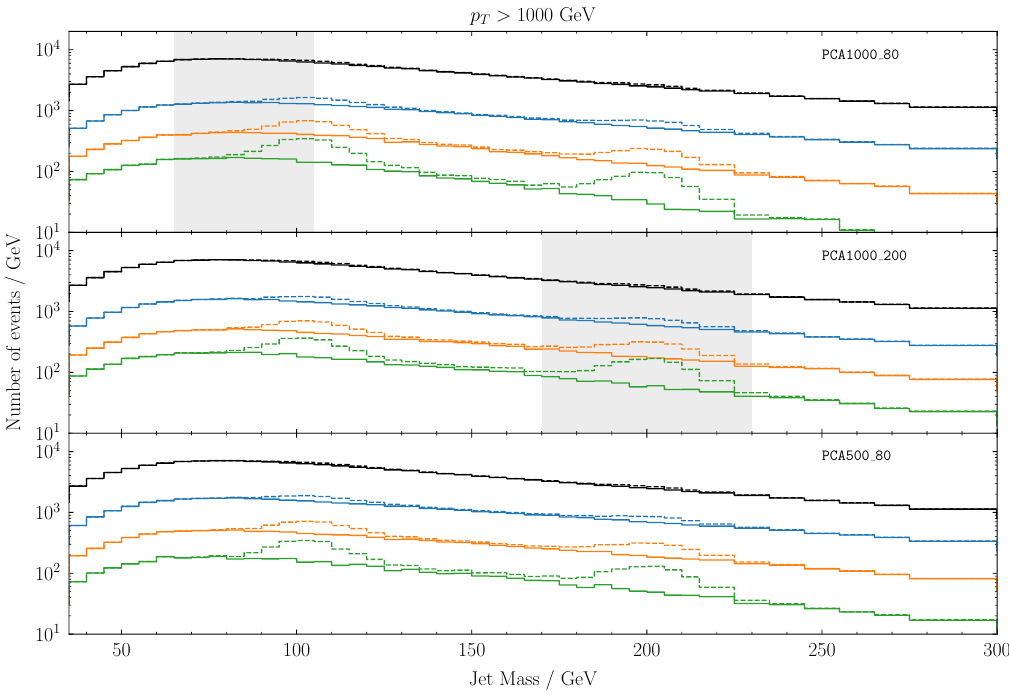
Figure 6 . Jet mass distributions for p T > 1000 GeV, selected with three taggers at various thresholds. Top: PCA1000 80 tagger. Middle: PCA1000 200 tagger. Bottom: PCA500 tagger. The solid lines correspond to the QCD jet background, and the dashed lines to the background plus injected signals. The shaded boxes show the jet mass intervals for which each tagger is